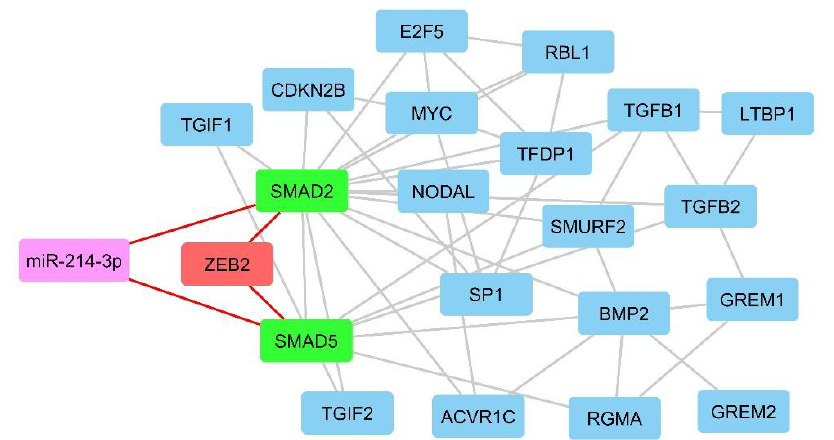
Figure 3. MiRwalk results show that miR-214-3p/ZEB2/SMAD-dependent TGF- β axis has an important role in glioblastoma induction or progression.